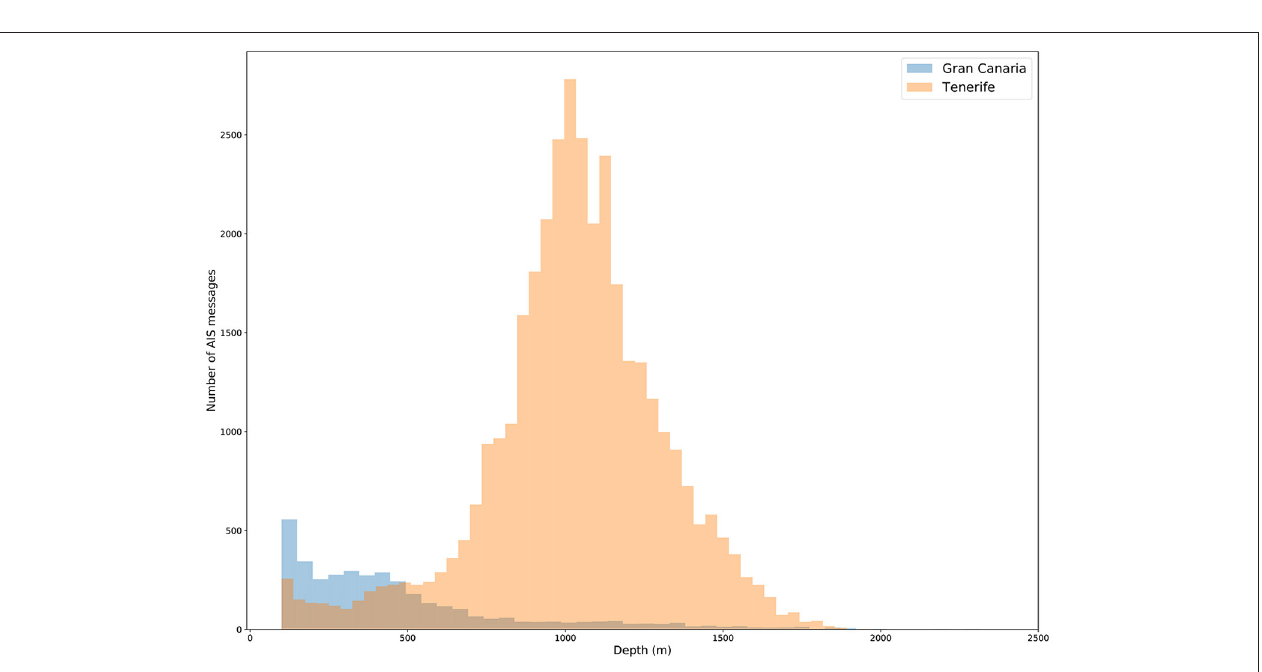
that it can vary when resident bottle-nose dolphins are found on the way to observe the pilot whales, or other transient whale or dolphin species are present in the area. A Python script was